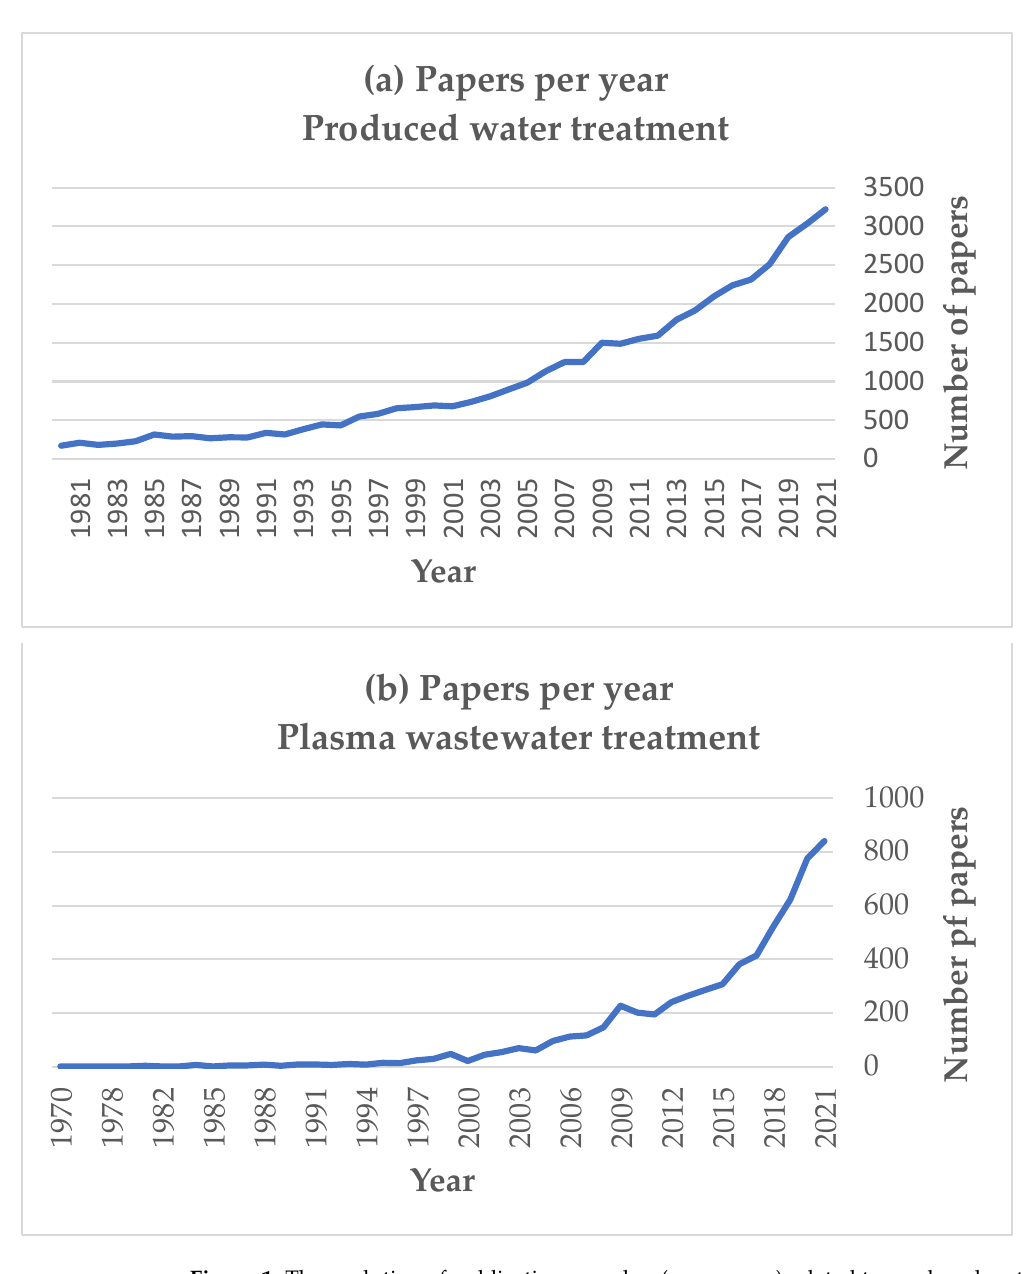
Figure 1. The evolution of publications number (per annum) related to produced water treatment ( a ) and plasma wastewater treatment ( b ). The data was acquired from Scopus database.